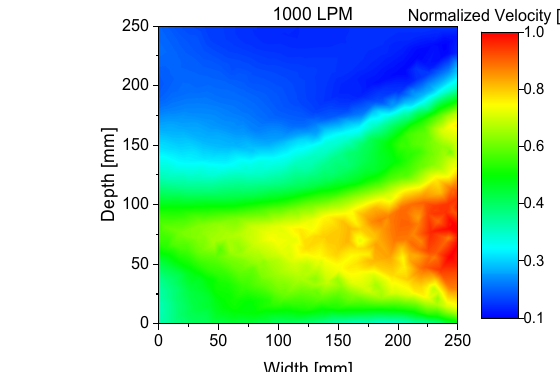
Figure 6. Velocity profiles normalized by maximum velocity in the center plane for different gas flow rates. ( Left ): 250 LPM and maximum velocity of 1.59 m/s. ( Right ): 1000 LPM and maximum velocity of 6.36 m/s.